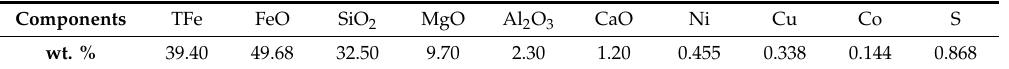
Table 1. Chemical components of nickel slag (mass fraction, %).